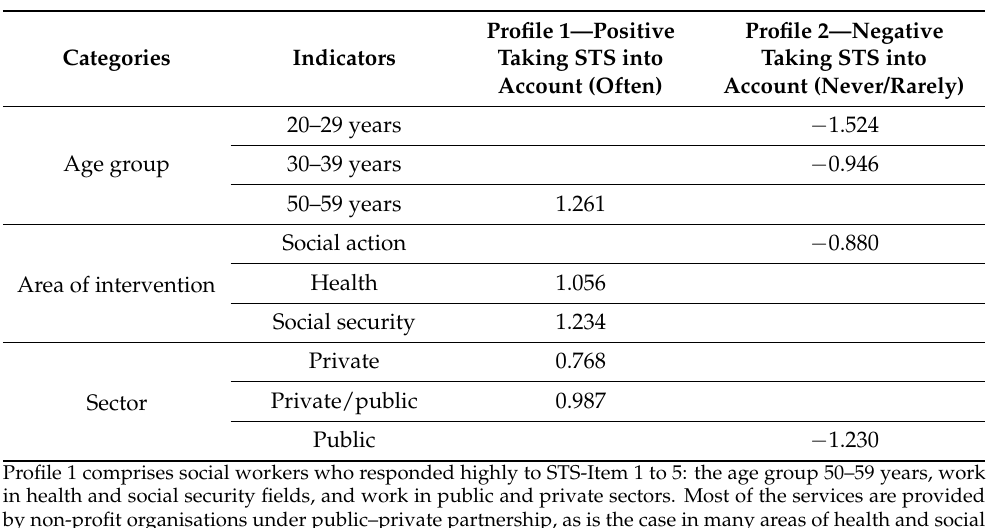
Table 4. Profile 1 and